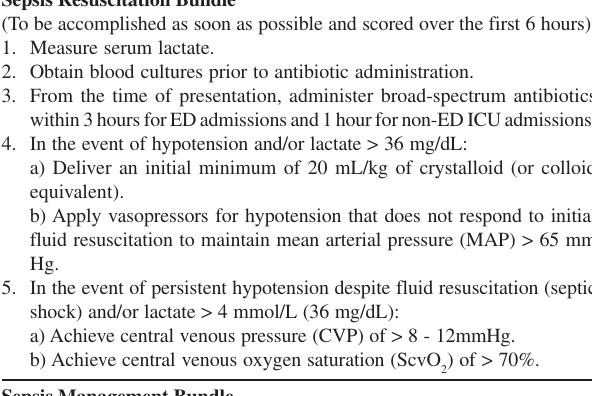
Table 3 - Severe Sepsis Bundles Sepsis Resuscitation Bundle (To be accomplished as soon as possible and scored over the first 6